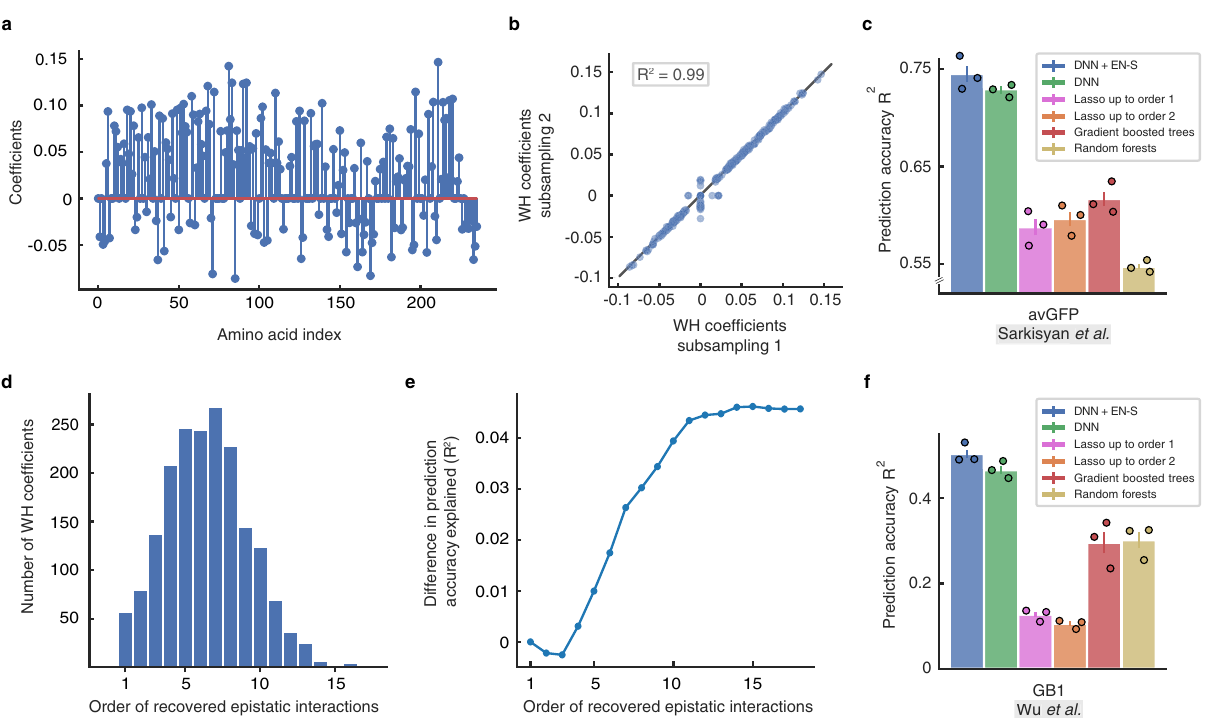
Fig. 4 Inferring epistatic interactions in two large canonical protein landscapes using the scalable Epistatic Net (EN-S) regularizer. a The fi rst-order Walsh-Hadamard (WH) coef fi cients of unregularized DNN trained on the Aequorea victoria (avGFP) landscape of Sarkisyan et al. 2 recovered by the peeling algorithm using a set of 5, 074, 944 uniformly subsampled proteins (out of 2 236 ). b The scatter plot of the fi rst-order WH recovered by EN-S using two independent sets of 5, 074, 944 uniformly subsampled proteins. The recovered coef fi cients are highly consistent (R 2 = 0.99). The higher variance of the scatter plot around the center shows the small number (20 out of 236) of coef fi cients that are differentially recovered. c DNN with EN-S regularization outperforms the baselines in terms of prediction accuracy in avGFP. d Histogram of the order of epistatic interactions recovered while training the EN-S regularized DNN. e The prediction accuracy gained by the higher-order epistatic interactions when added to a purely linear model. f DNN with EN-S regularization outperforms the baselines in terms of prediction accuracy in the GB1 landscape of Wu et al. 1 . Error bars show the standard error of the mean (SEM) in 3 independent repeats of the experiments with random splits of the data into training, validation, and test